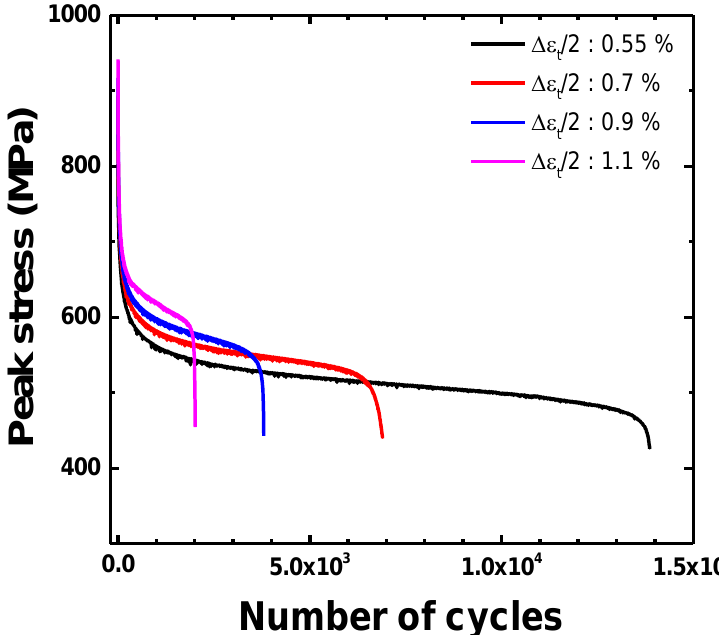
Figure 6. Cyclic stress responses with the total strain amplitude.